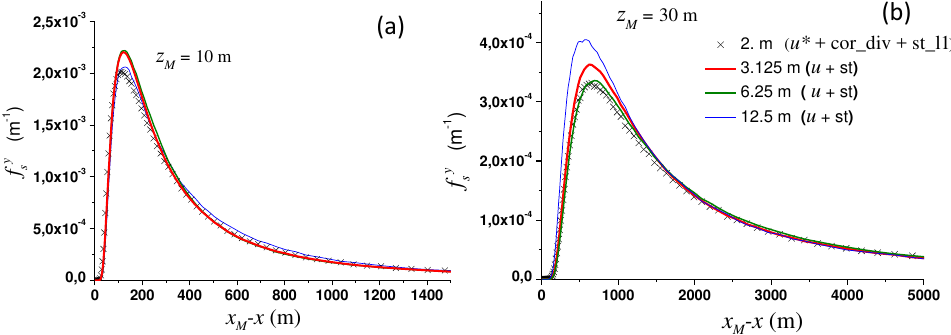
D E s (cid:48) 2 Figure 5. (a) Variance σ 2 s = of the concentration of Eulerian scalar (solid lines) and variance σ 2 sp = mined by Lagrangian particles (symbols); grid steps and the methods of calculations are shown in the legend, and symbolic notations are the same as in Fig. 4; stars – a stochastic model (LSM, Eqs. 28–32) is used throughout the domain. Open circles – a subgrid RDM (Eq. 33) is (cid:11) /(σ sp σ s ) between “Eulerian” and “Lagrangian” concentrations. For remaining notations, see applied. (b) Correlation corr (s,s P ) = (cid:10) s (cid:48) s (cid:48) P xyt